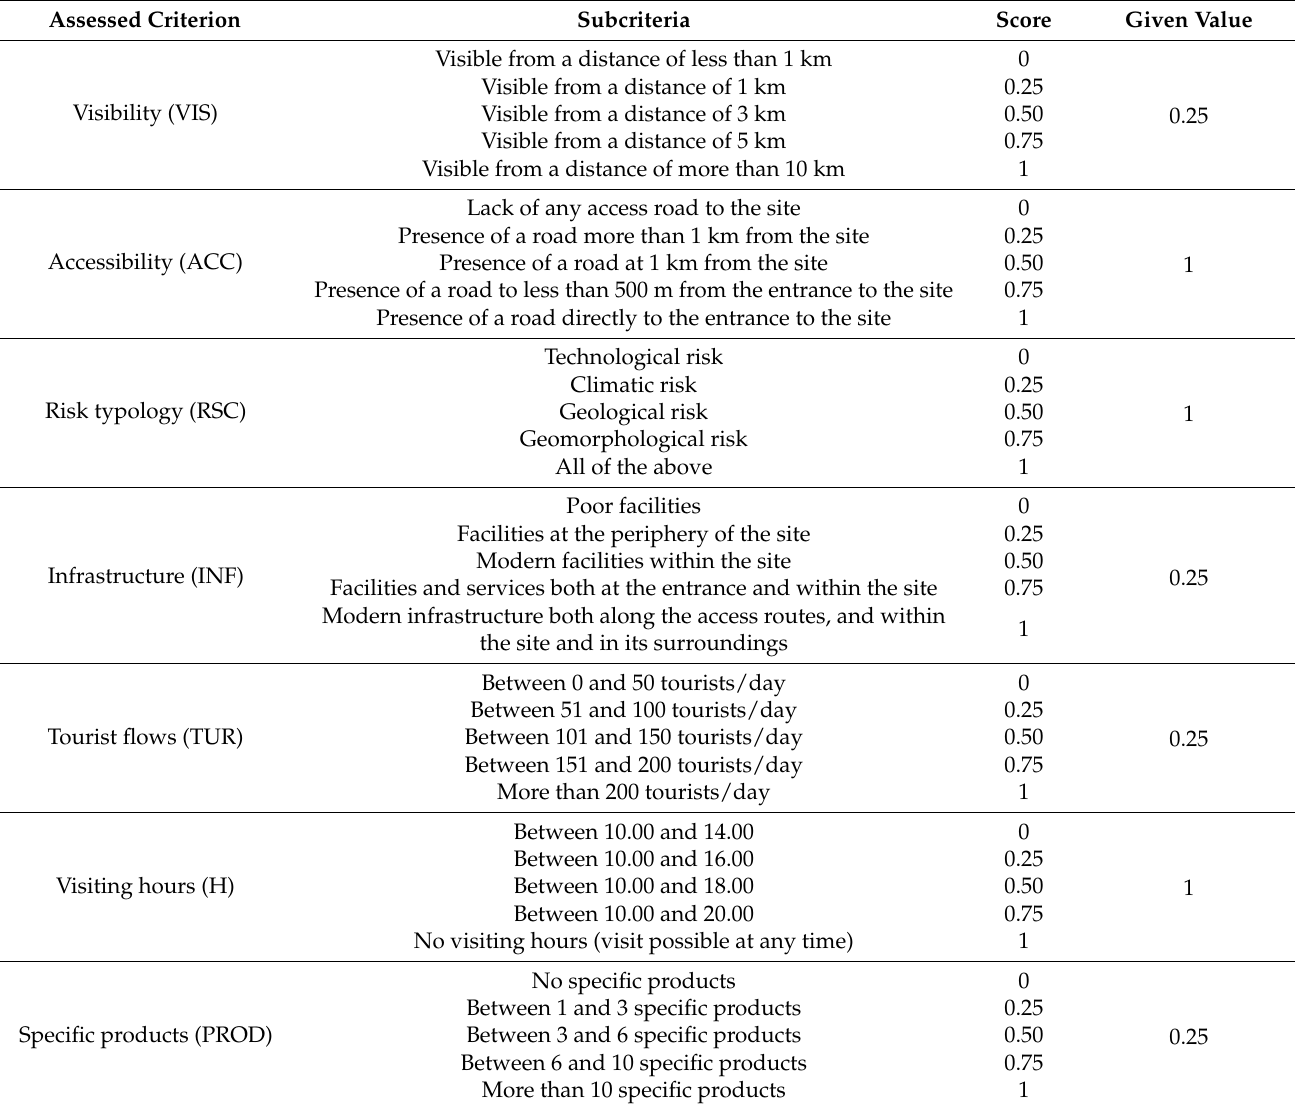
Table 5. The degree of use (V UTIL